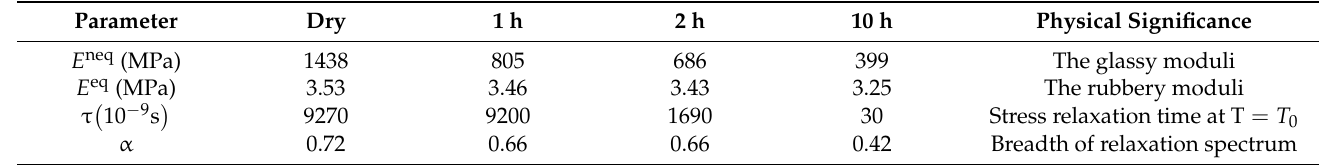
Table 5. Parameters of the fractional Zener model for polymers with 20 wt.% crosslink density.